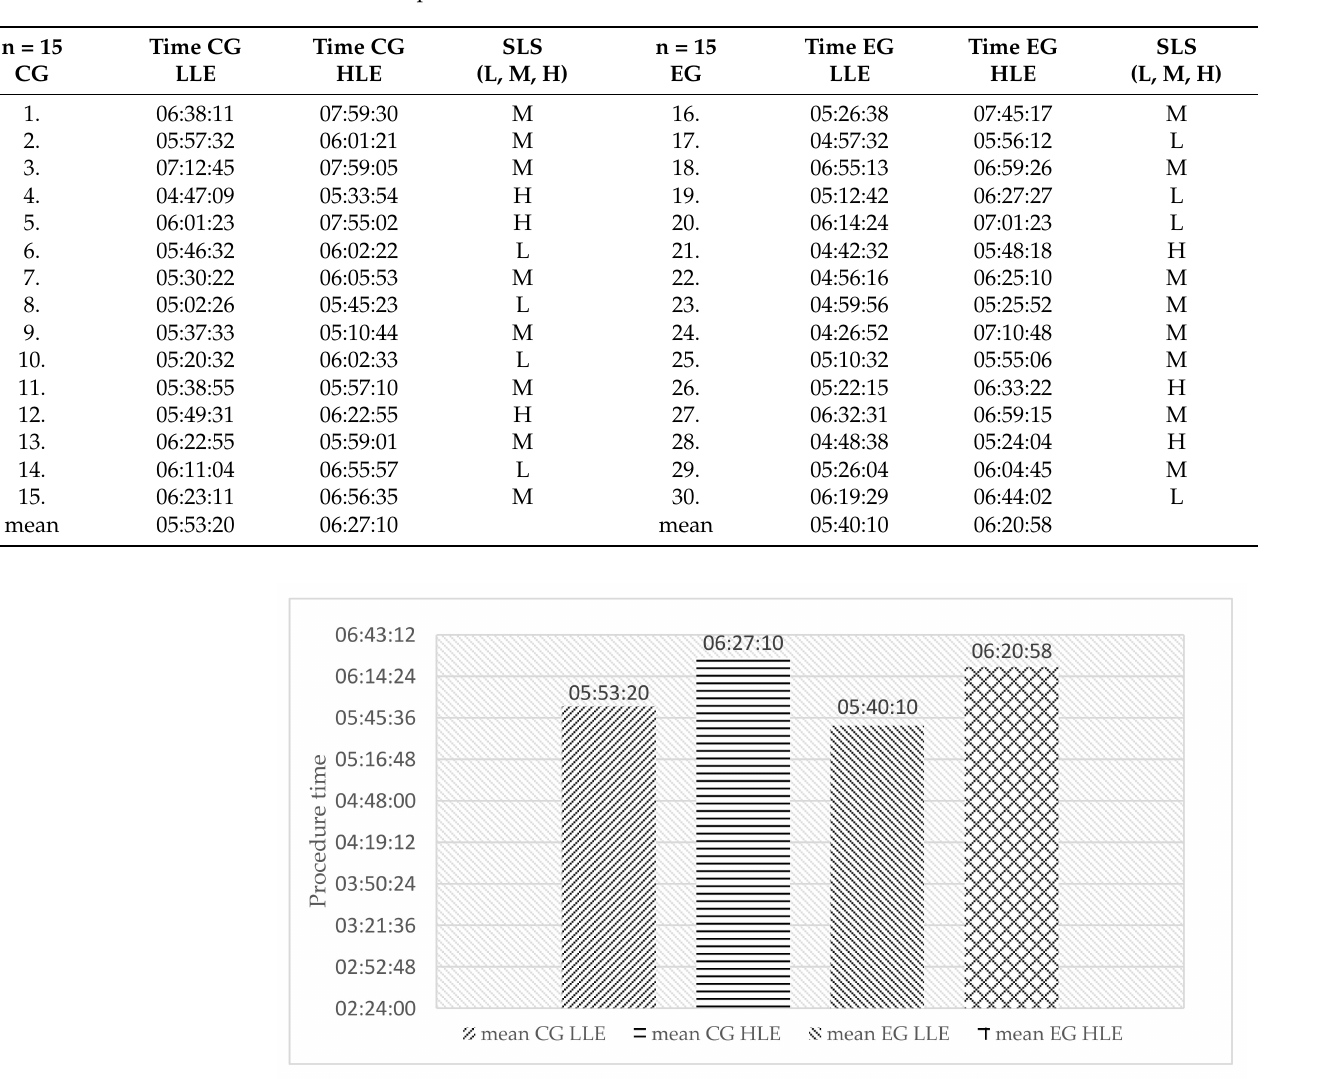
Figure 6. Time measurement of procedure time CG and EG, LLE and